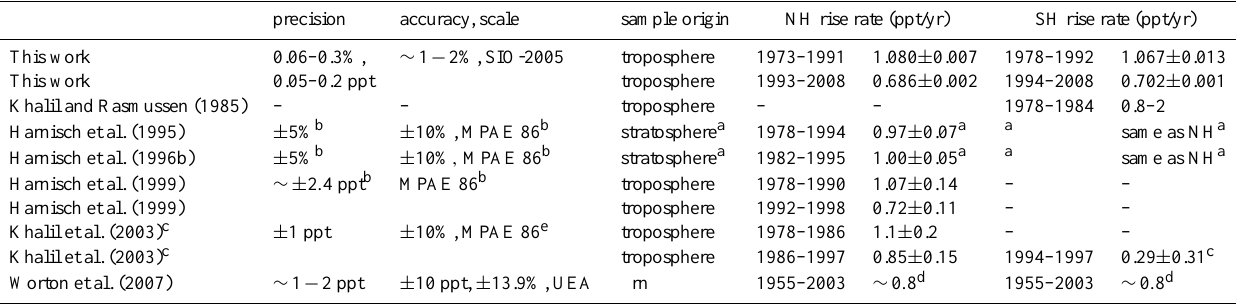
Table 3. CF 4 measurement precisions, scale accuracies, sample origins, and tropospheric